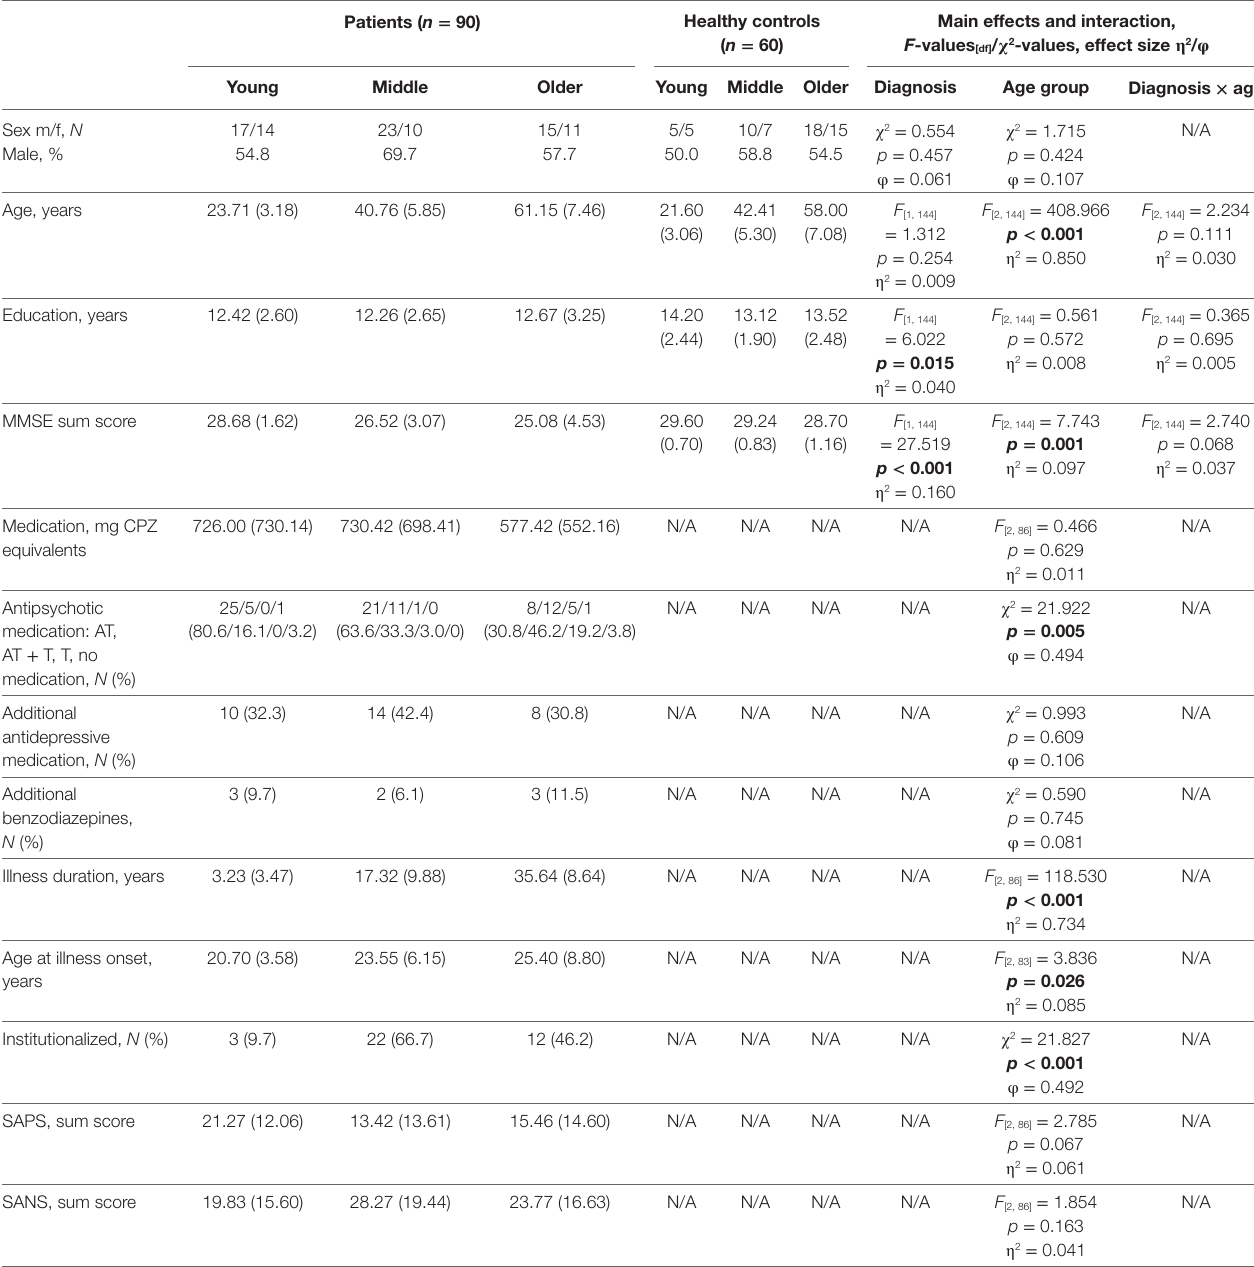
Table 1 | Demographic and clinical characteristics of patients and healthy